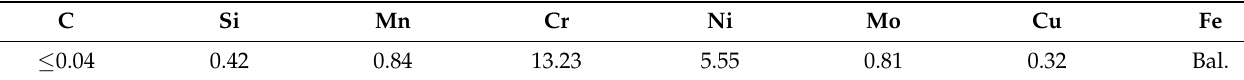
Table 2. Nominal chemical composition of the SMSS feedstock solid wire (wt.%).